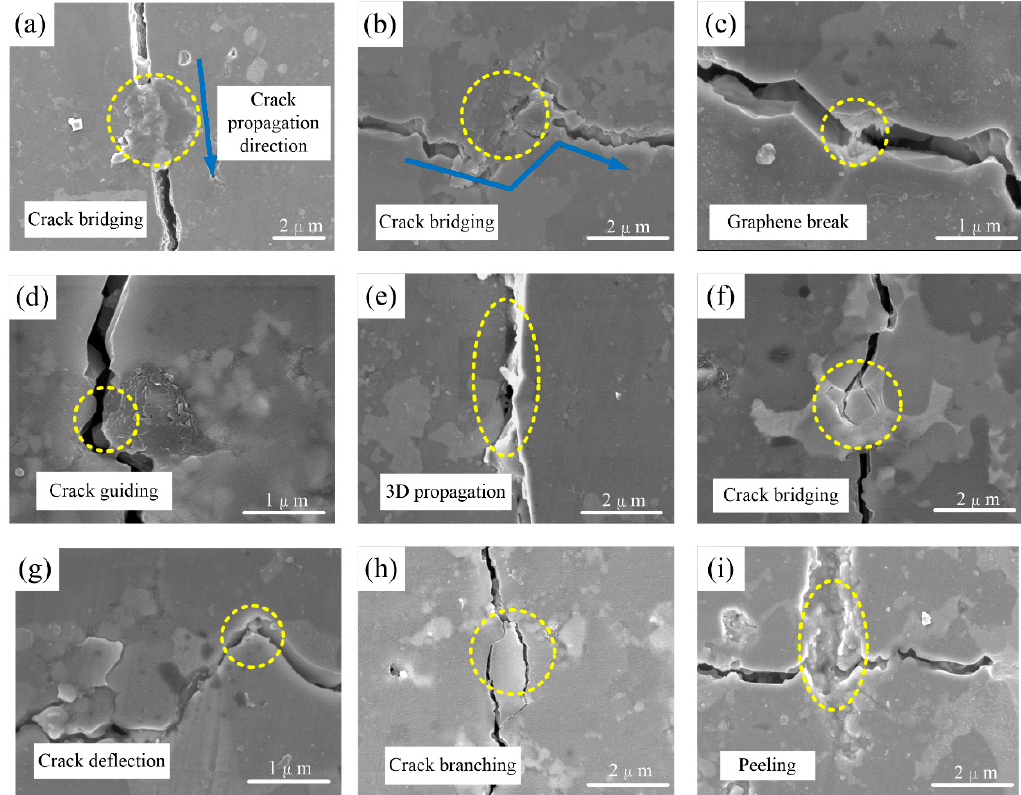
Figure 10. Indentation crack morphologies of reinforcing mechanisms induced by graphene and nano-TiC. ( a , b ) crack bridging, ( c ) graphene break, ( d ) crack guiding, ( e ) 3D propagation, ( f ) crack bridging, ( g ) crack deflection, ( h ) crack branching, ( i ) peeling.